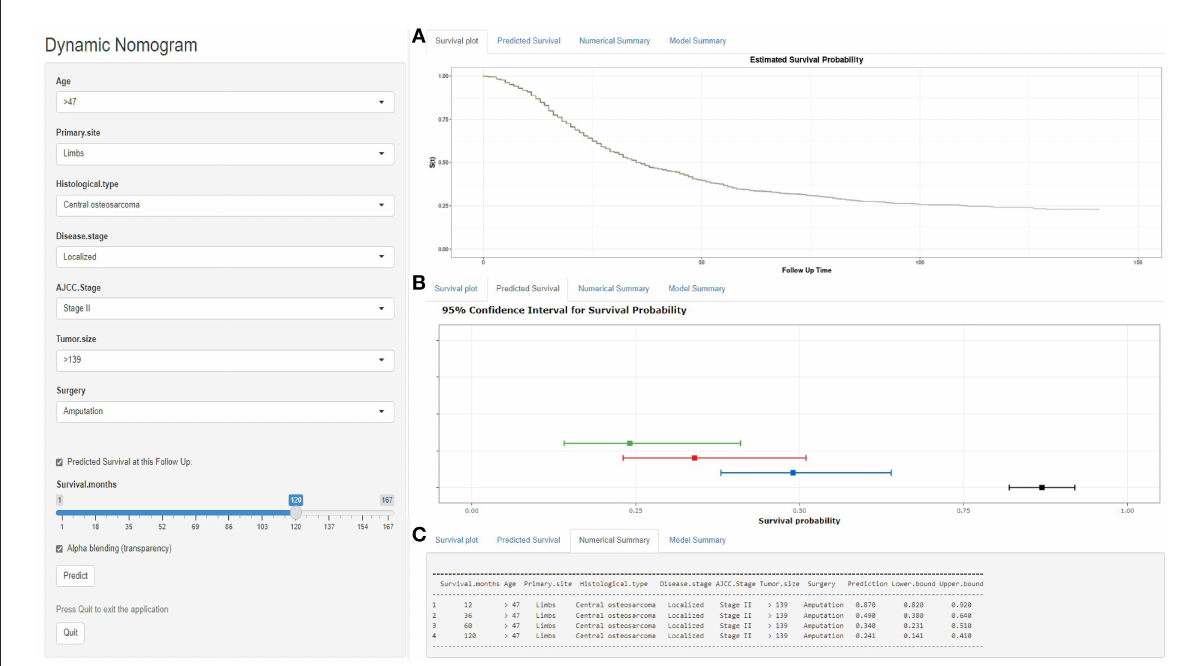
FIGURE6 A web-based nomogram for predicting OS after surgical resection in patients with primary osteosarcoma. (A) The curve of the estimated probability of survival for this patient over time. (B) 95% confidence intervals of the 12-, 36-, 60-, and 120-month survival probabilities for this patient. (C) Numerical summary of the 12-, 36-, 60-, and 120-month survival probabilities for this patient. Due to a large number of visitors to the webpage, if the application cannot be used normally, please click “Quilt” or “Reload” in the lower-left corner to try